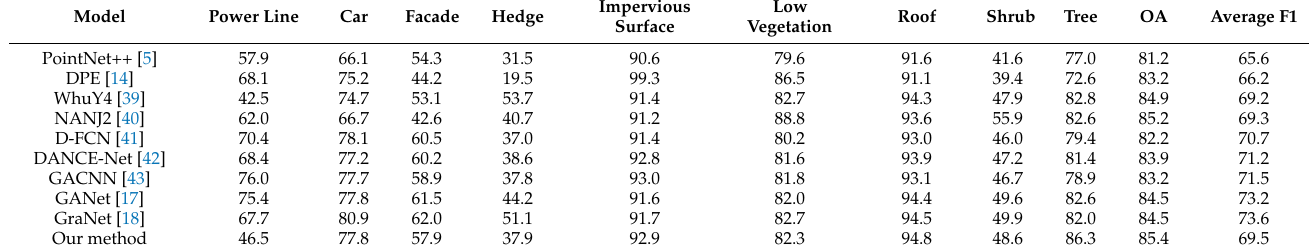
Table 7. Comparison of F1 score and OA of different methods (%).